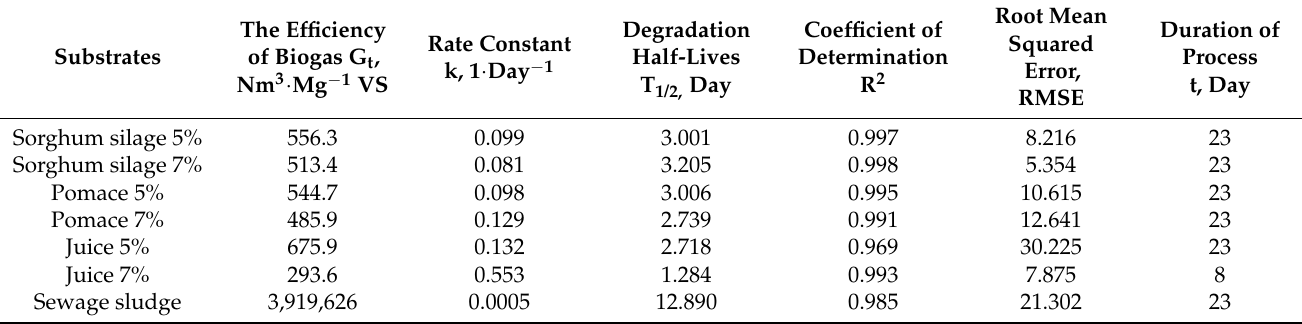
Table 4. Kinetic biogas parameters in Tabasarana